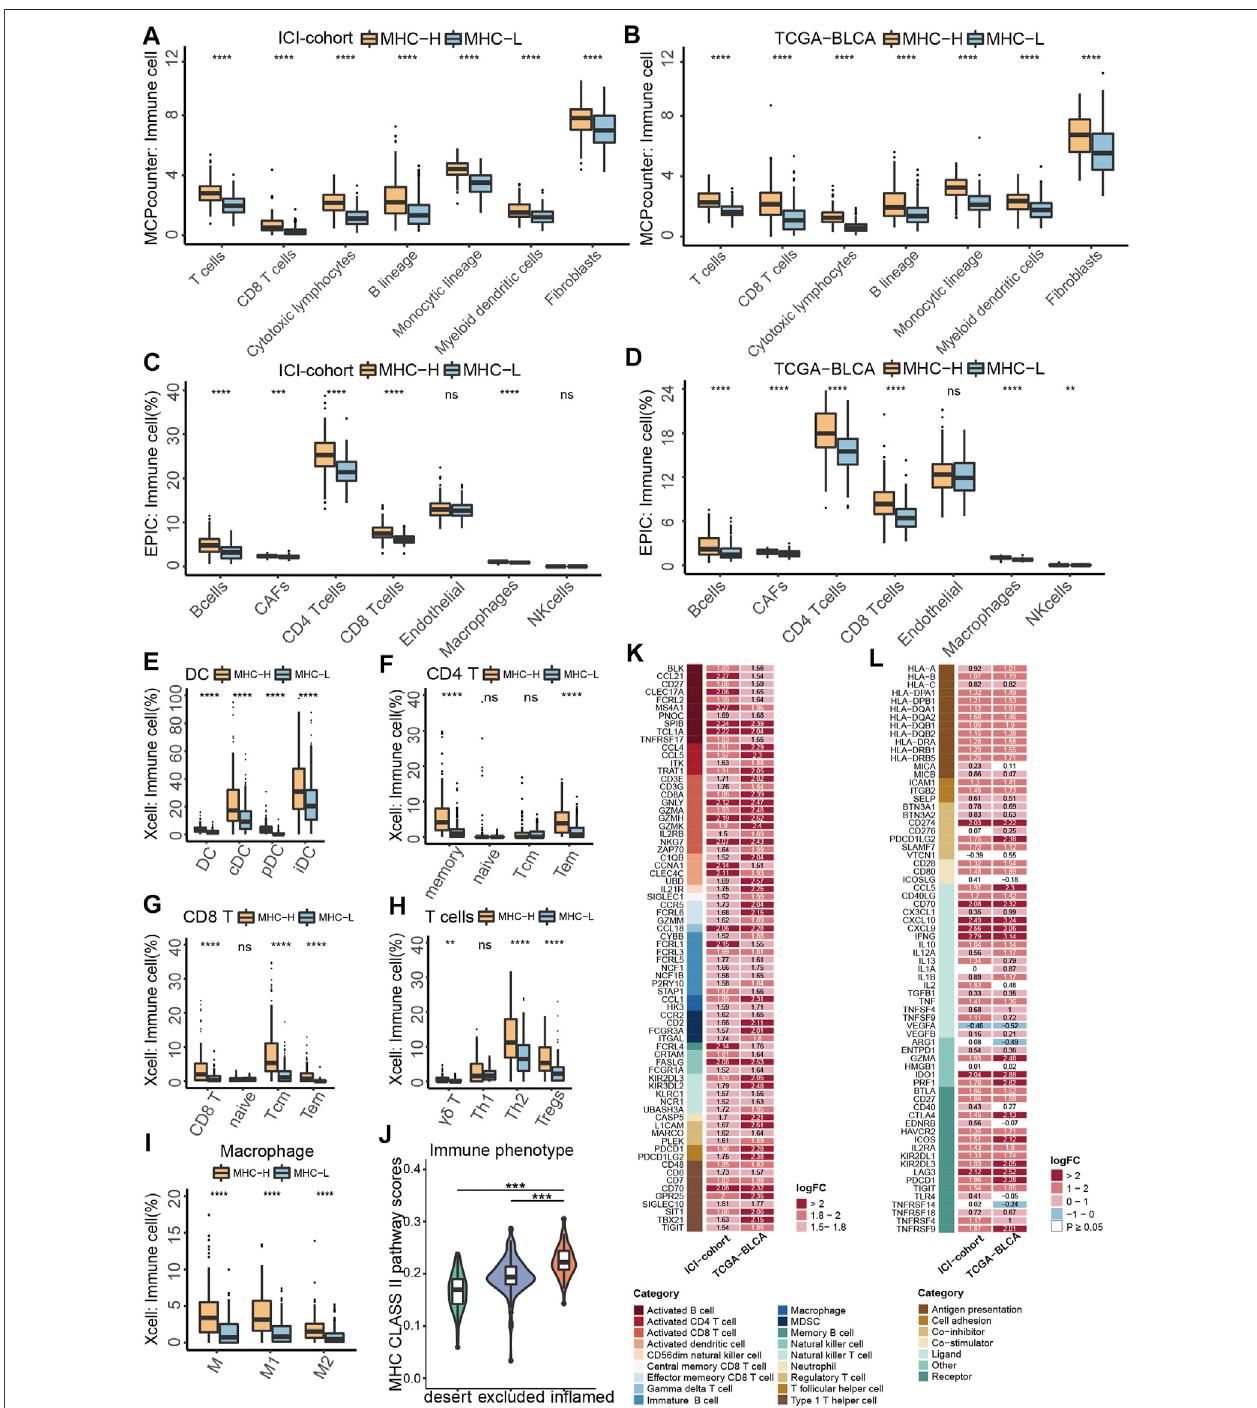
FIGURE 4 | MHC-II signature shows correlation with immune cell in fi ltration and anti-tumor immunity. (A,B) MCP-counter analyses quantifying immune cells and stromalcellsinMHC-HandMHC-LgroupsinICI-cohort (A) andTCGA-BLCAcohort (B)(C,D) EPICanalysesquantifyingthein fi ltrationratioofimmunecellsoftheMHC- H and MHC-L groups in the ICI-cohort (C) and TCGA-BLCA cohort (D) (E – I) xCell analyses estimate the abundance scores of 64 kinds of immune cells in the MHC-H andMHC-LgroupsintheICI-cohort.Dendriticcells (E) includeconventionaldendriticcells(cDCs),plasmacytoiddendriticcells(pDCs)andimmaturedendriticcells (iDCs); CD4+T cells (F) include CD4+memory Tcells, CD4+naive T cells, CD4 + central memory T cells and CD4 + effector memory T cells; CD8+T cells (G) include CD8 + naiveTcells,CD8 + TcentralmemoryTcellsandCD8 + TeffectormemoryTcells;othertypesofTcells (H) includeTcellgammadeltacells(Tgd),Thelper2cells(Th2)and regulatory cells (Tregs). Macrophages (I) include M1 macrophages and M2 macrophages. (J) Violin plot showed the distribution of tumor immunophenotype in the